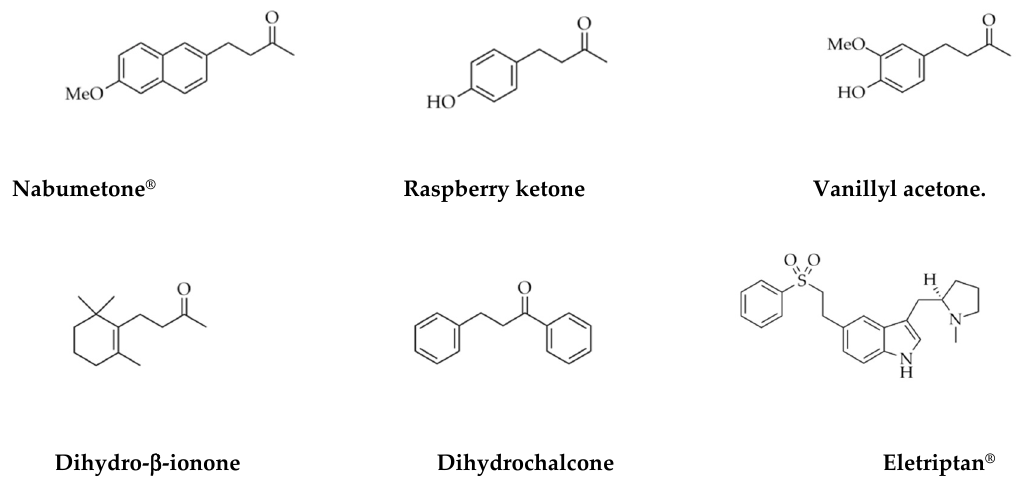
Scheme 2. Selectively hydrogenated products